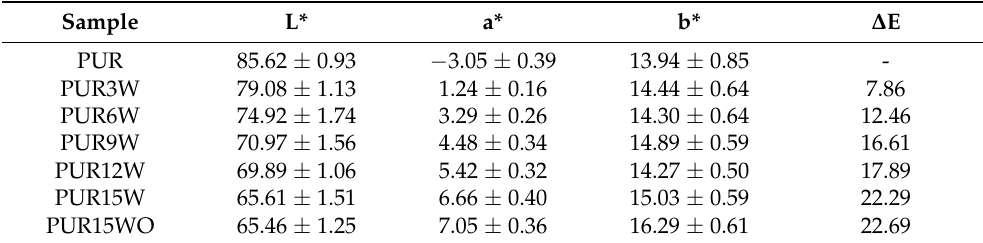
Figure 9. SEM images made for reference PUR and PUR 15W and PUR 15WO in SE and BSE mode showing the dispersion of the filler in a foamed polymeric matrix. Table 4. CIELab color parameters and ∆ E of PUR and PUR-W/WO